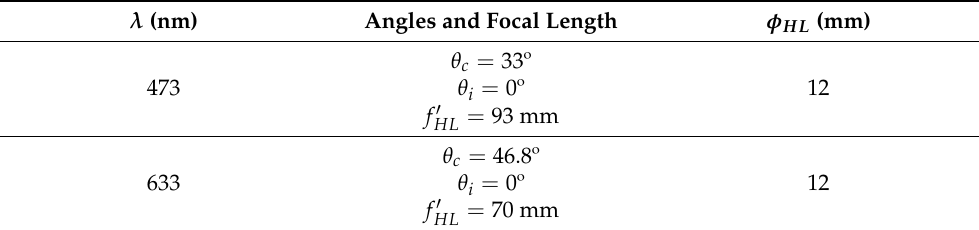
Table 2. HL parameters for the reconstruction